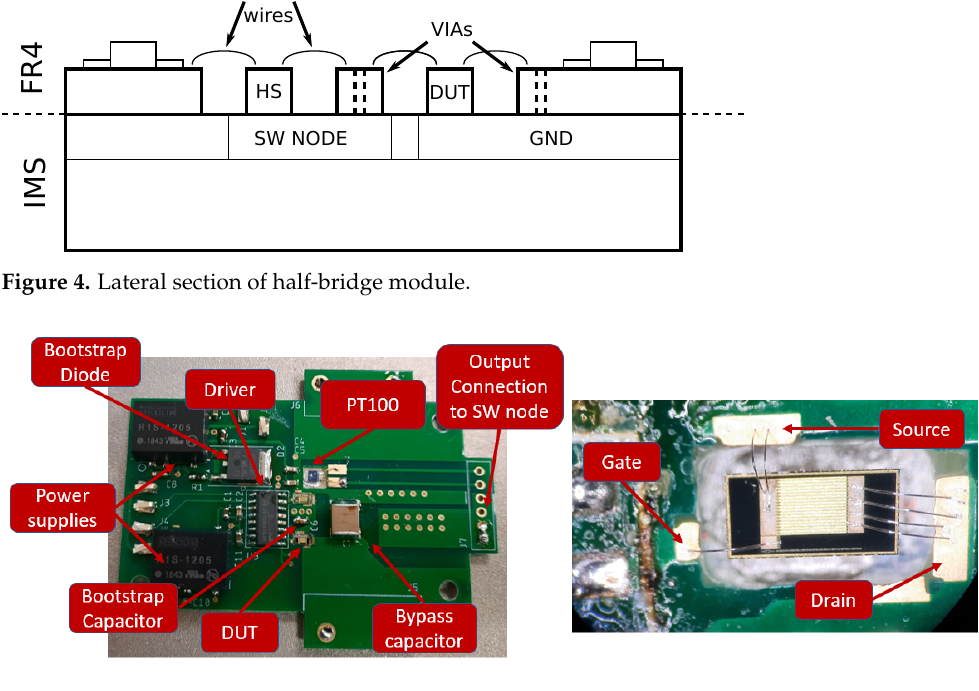
Figure 5. Photograph of the implemented half-bridge module with magnification of the die connec- tions to FR4 board with wire